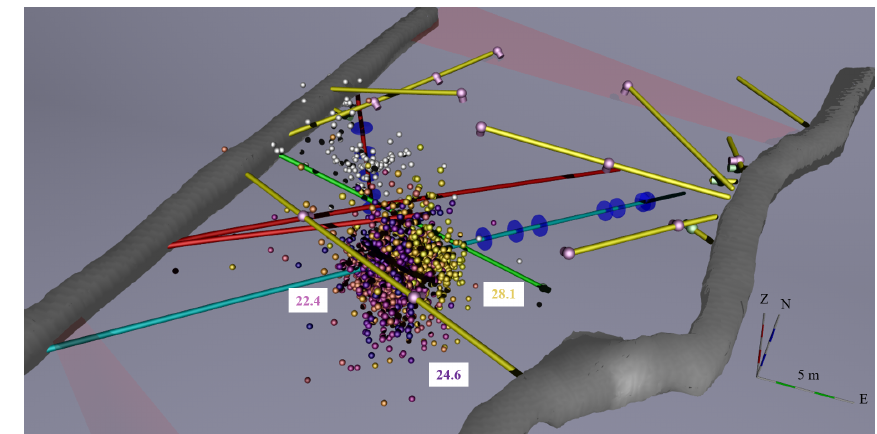
Figure 5. AE locations obtained for stimulations in the injection borehole (coloured dots according to stimulated interval as marked) and the vertical validation borehole (white dots). See Fig. S5 for different 3-D views. Note that the intermediate-depth and deep stimulated intervals in the injection borehole produced little to no AE activity.